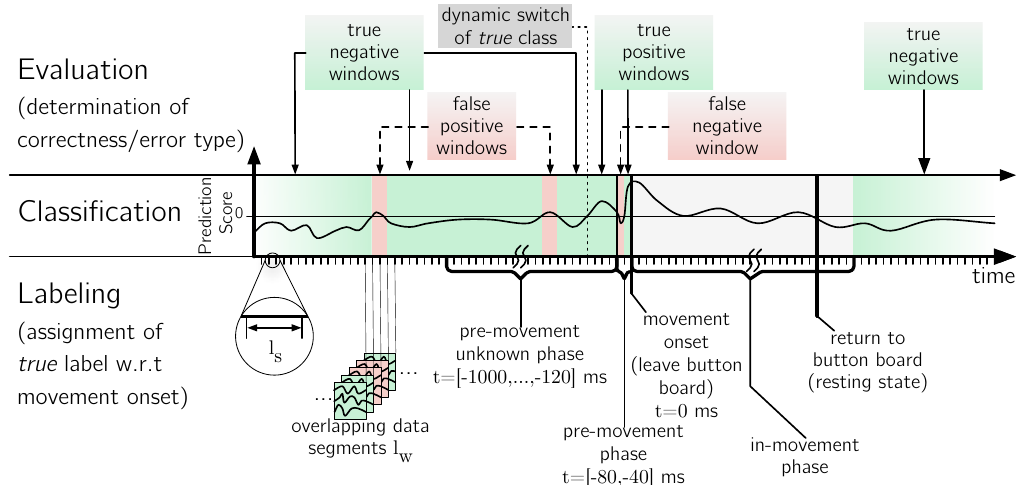
Figure 3. Segment-based evaluation. The true label was assigned to each segment based on the temporal relationship to a movement onset. Since we observed highly subject-specific differences of the time when a movement can be predicted before the actual movement onset, we used the following dynamic method to determine whether the true class of a segment is the movement or rest. In all cases the segments ending at 80 or 40ms relative to the movement onset were expected − − to predict a movement (i.e., belong to the movement class, denoted as pre-movement phase). All segments ending in the interval [ 1s,. . . , 120ms ] were further investigated whether they belong − − to a consecutive sequence of predictions of the movement class with at most one exceptional case (pre-movement unknown phase). All segments ending between the movement onset and the end of the movement plus an additional tolerance period of 200ms were not included in the performance evaluation (post-movement phase). All remaining segments were assigned to the resting class. For training of the classifier, the segments ending in the interval [ 120, . . . ,120 ] ms were used as examples − for the movement class, all remaining segments (apart from examples ending in the in-movement phase) were used as examples for the resting